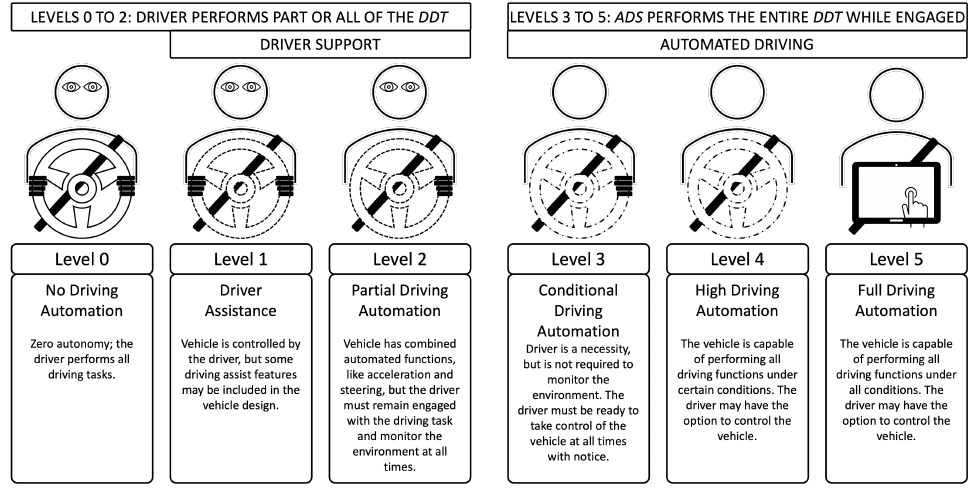
Figure 1. Society of Automotive Engineers (SAE) levels for driving automation following On-Road Automated Driving (ORAD) committee, SAE International [1] with Dynamic Driving Task